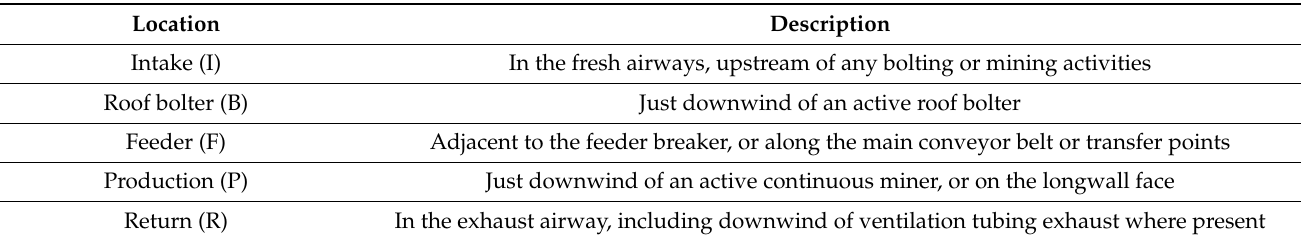
Table 2. Description of the five key sampling locations within each